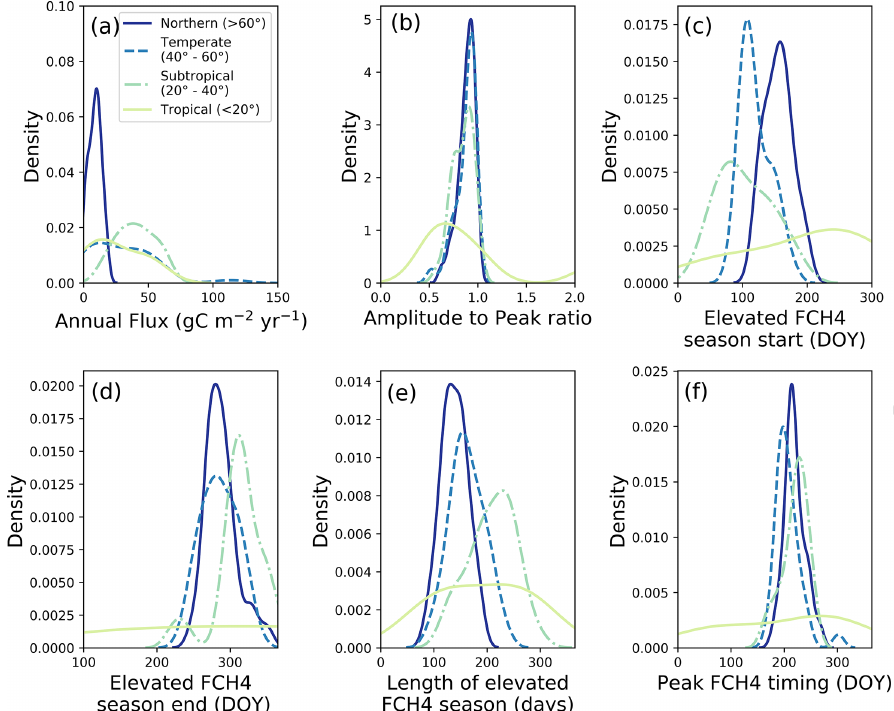
Figure 8. (a) Annual methane (CH 4 ) flux (gCm − 2 yr − 1 ), (b) ratio of seasonal amplitude to seasonal peak, where values of 0 indicate uniform annual CH 4 flux, values of 1 indicate zero off-season fluxes, and values exceeding 1 indicate negative off-season fluxes, (c) CH 4 flux (FCH 4 ) elevated emission season start by day of year (DOY), (d) FCH4 elevated emission season end by DOY, (e) length of elevated CH 4 flux season (days), and (f) DOY of peak FCH 4 . Northern (dark blue, solid line), temperate (blue, dashed line), sub-tropical (green, dot-dash line), and tropical (light green, solid line) wetlands plotted using the kernel density function. Each panel has lines that represent latitudinal bands as follows: northern ( > 60 ◦ ), temperate (between 40 and 60 ◦ ), subtropical (between 20 and 40 ◦ ), and tropical ( < 20 ◦ ), though the site- year totals vary between these groups ( n = 57, n = 36, n = 39, and n = 9 respectively). All total CH 4 flux values and elevated season start values are positive, and the apparent continuation of the data distribution into negative values is an artifact of the kernel density function. Southern Hemisphere sites below 20 ◦ S were shifted by 182d to make summer the middle of the year for comparability with Northern Hemisphere